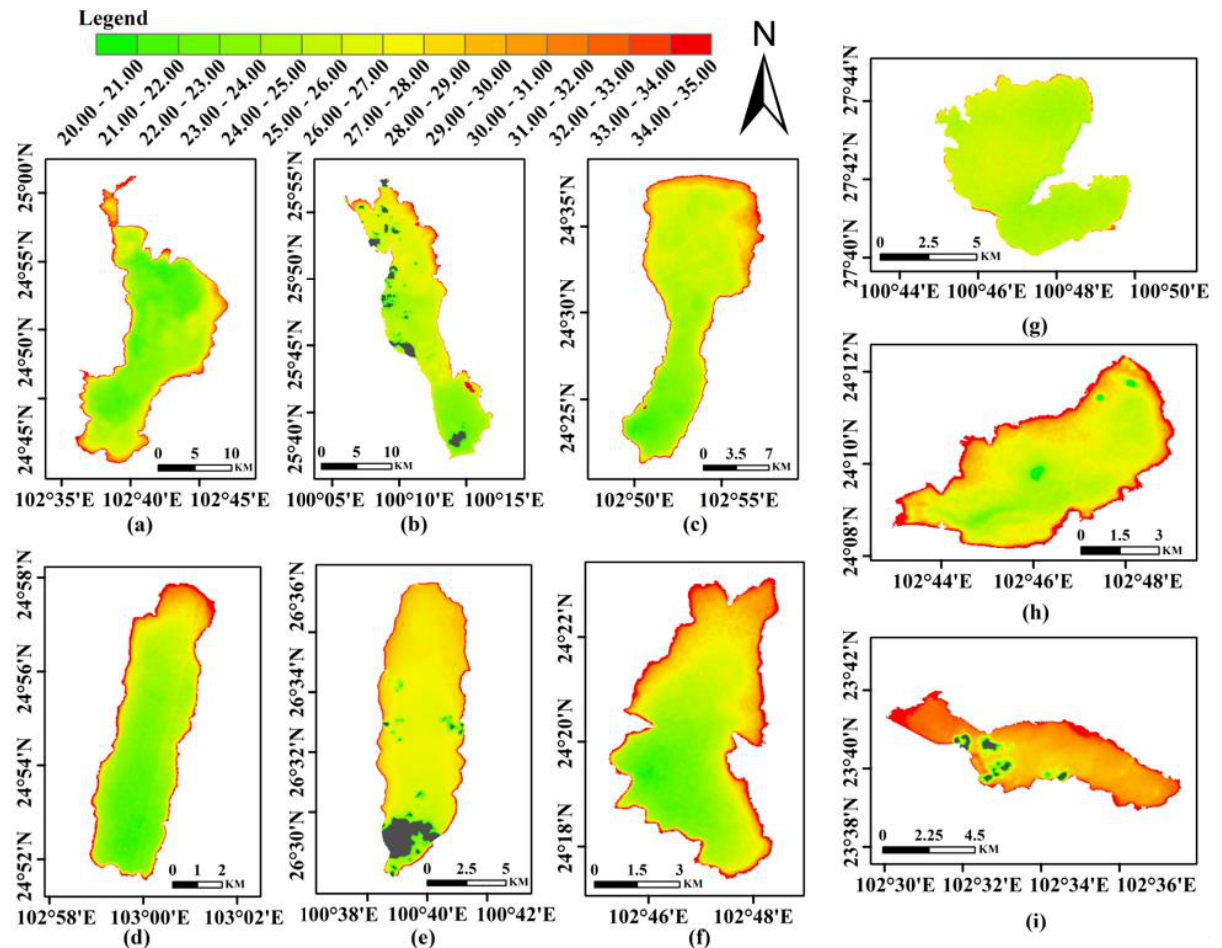
Figure 5. Retrieval of the water surface temperatures in nine plateau lakes on June 22 and 24, 2020.